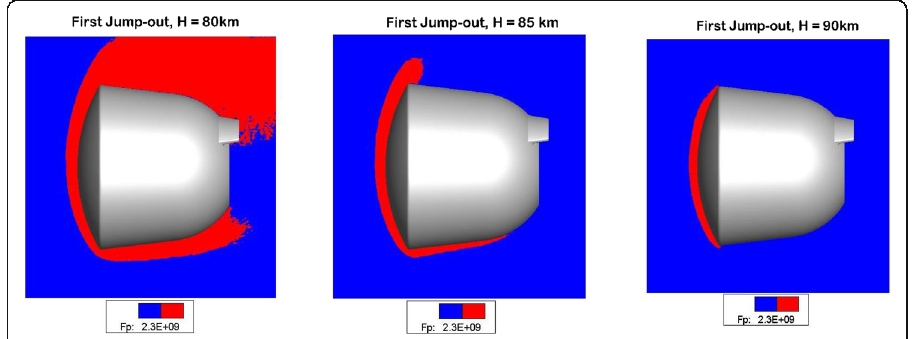
Fig. 20 The corresponding electromagnetic wave frequency of the lunar exploration type capsule at different altitudes for the first jump-out (Unit: